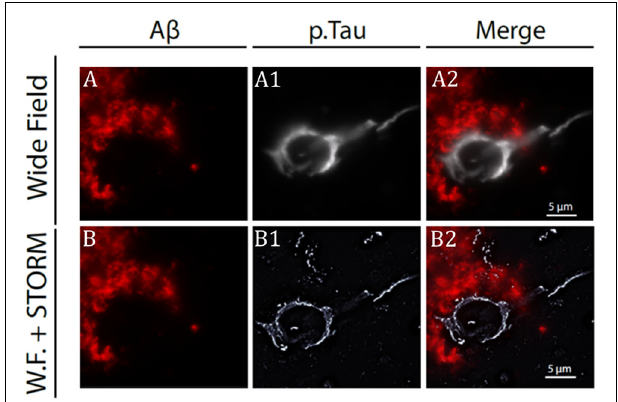
FIGURE 1 | Stochastic optical reconstruction microscopy (STORM) image of beta-amyloid plaque and neurofibrillary tangles (NFT) in Alzheimer’s disease (AD) patient brain slice. (A) Confocal microscopy image of beta-amyloid aggregates (in red) and neuro-fibrillary tangles (A1) from an AD patient brain specimen. Super-imposed images are shown in panel (A2) . Same senile plaque as in panel (A) , imaged by combining fluorescence microscopy for beta-amyloid aggregate (B) with STORM microscopy for NFT (B1) . Super-imposed images are shown in panel (B2) . Note the difference in resolution between image in panels (A2) and (B2) . Modified from Codron et al. (2020) under the Creative Commons